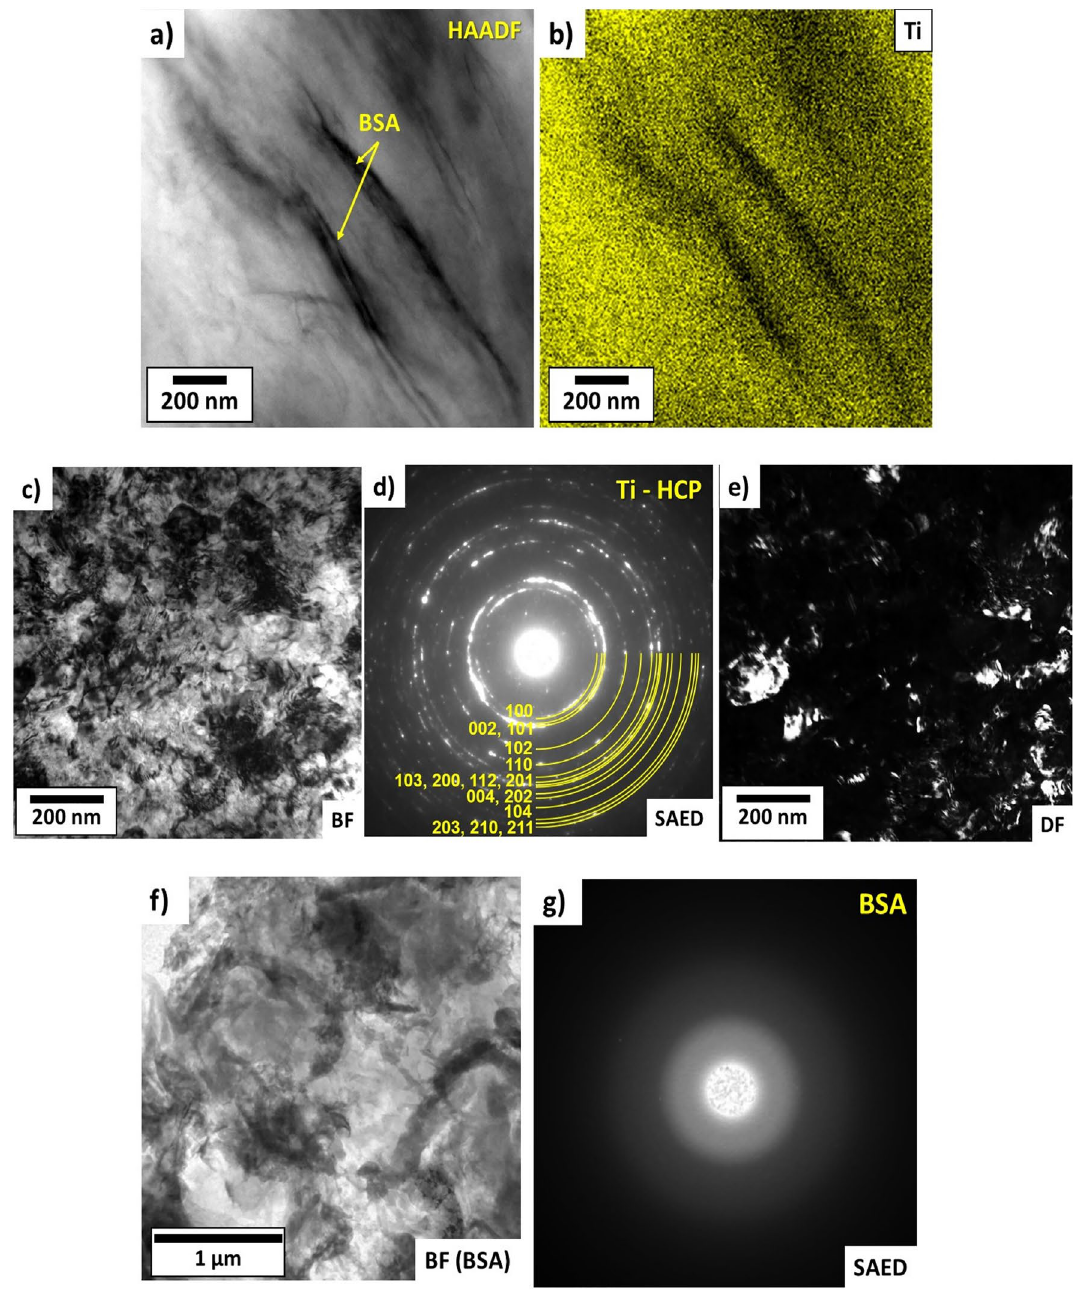
Figure 2. STEM and TEM analyses for Ti + 5 vol % BSA composite after 5 turns of HPT under 2 GPa. ( a ) HAADF image and ( b ) and corresponding EDS mapping with Ti; ( c , f ) TEM-BF images; ( d , g ) SAED patterns corresponding to ( c , f ); and ( c ) TEM-DF